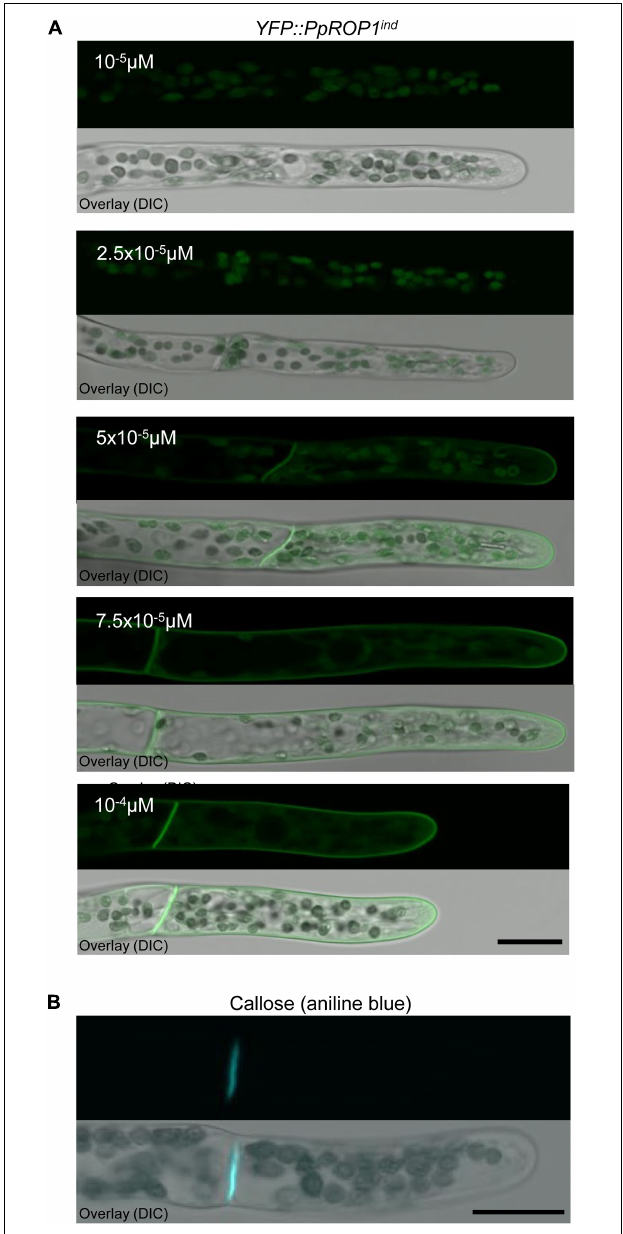
FIGURE 8 | Analysis of callose accumulation in the cell wall and of the intracellular distribution of YFP::PpROP1 expressed at different levels in apical cells of YFP::PpROP1 ind protonemata induced with estradiol at a range of concentrations. (A) Medial confocal optical sections through the tips of YFP::PpROP1 ind protonemal filaments grown in the presence of estradiol at the indicated concentrations (upper panels). Only background chlorophyll autofluorescence also displayed by WT cells ( Figure 3A ) was visible after induction with 10 − 5 M or 2.5 × 10 − 5 M estradiol. At each of the estradiol concentration tested, all imaged apical cells displayed essentially identical fluorescence emission patterns ( n = 20). Overlay (lower panel): the fluorescence image shown in the upper panel overlaid onto a transmitted light reference image (differential interference contrast, DIC). Scale bar = 25 µ m. (B) Medial confocal optical section through the tip of a WT protonemal filament stained with aniline blue to visualize callose in the cell wall. All